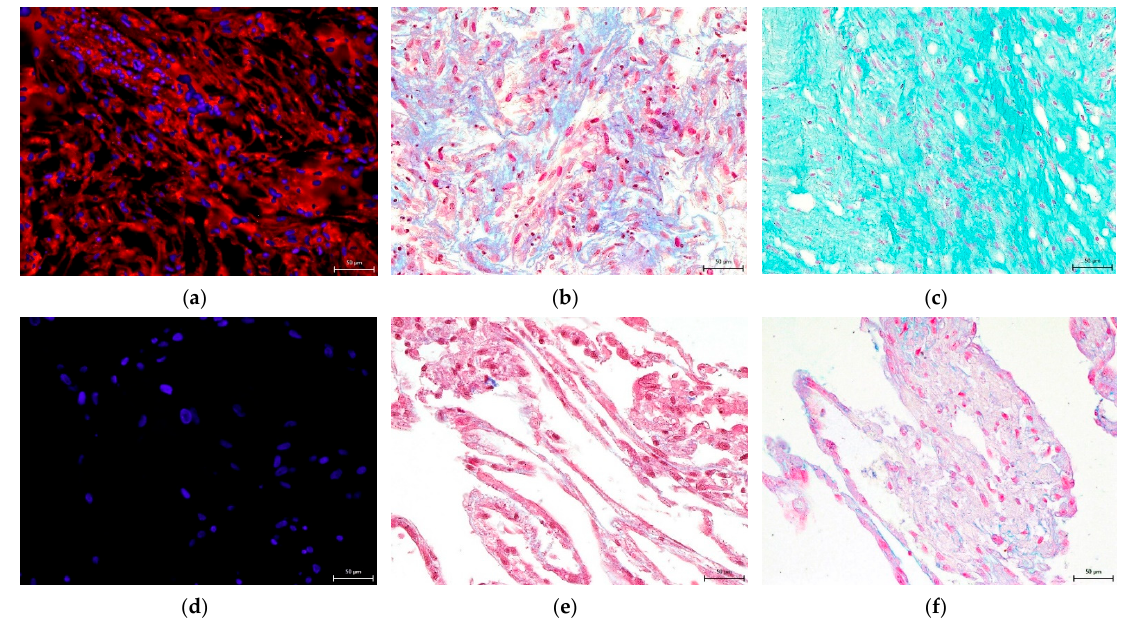
Figure 11. Detection of chondrogenic differentiation in the extracellular matrix of hNDP-SCs culti- vated in the hPL-culture medium. Scale bar 50 μ m: ( a – c ) After 3-week cultivation in chondrogenic differentiation medium; ( d – f ) undifferentiated hNDP-SCs; ( a , d ) immunocytochemical detection of collagen type II (red fluorescence); ( b , e ) histological detection of collagen and procollagen after blue Masson’s trichrome stain (blue areas); ( c , f ) histological detection of acid mucopolysaccharides after Alcian blue stain (turquoise areas).